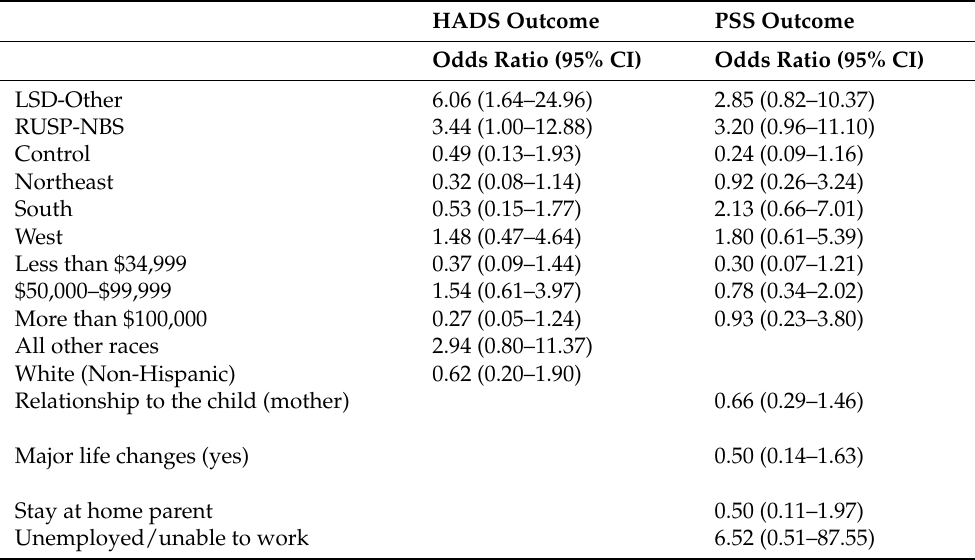
Table 3. Exponentiated results of binary logistic regression for diagnostic group on HADS/ PSS outcome.